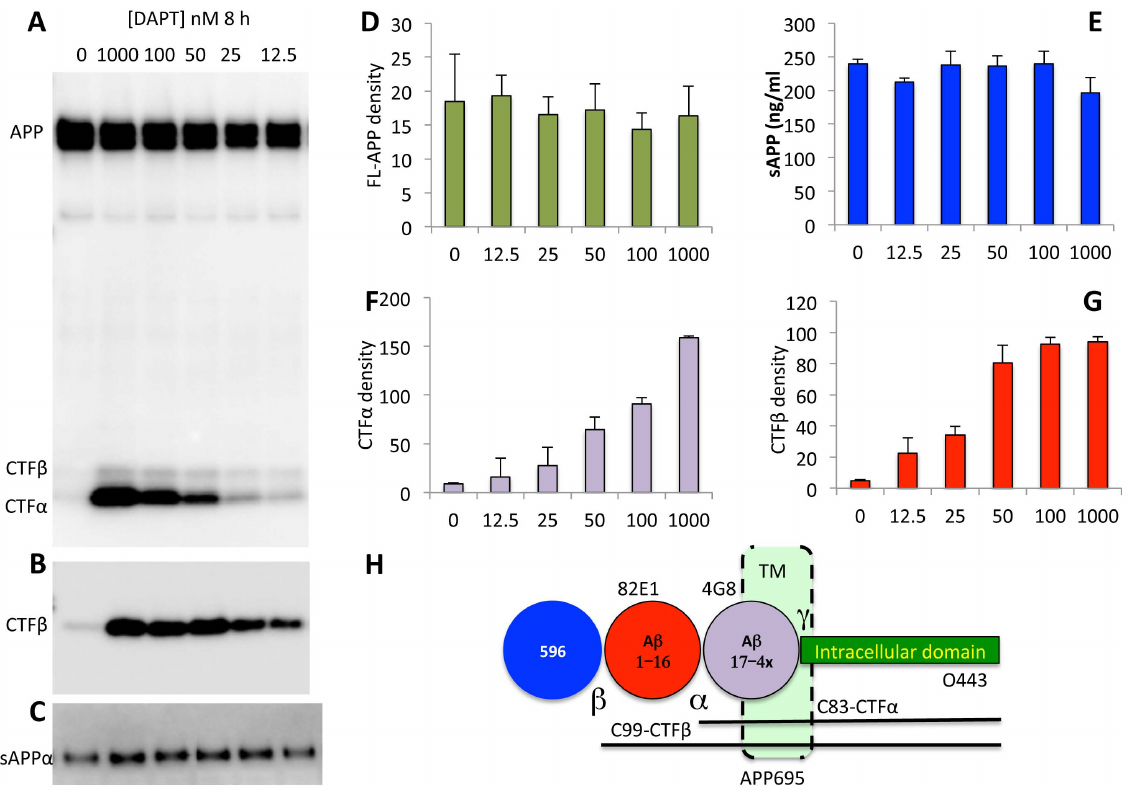
Figure 3. DAPT induced increase in A b does not alter APP processing. Western blots of cell lysates of SH-SY5Y cells from Fig 2 were detected in triplicates using the O443 antibody (A) and 82E1 (B); and media were analyzed with the WO2 antibody against A b 1-16 (C) as described in Materials and Methods. Full-length APP from A (D), CTF a from A (F) and CTF b from B (G) were quantified using the AlphaEase software and total sAPP (E; measured by an ELISA assay from R&D systems) were plotted as bar graphs. Full-length and secreted APP in panels D and E are not different from vehicle-treated controls. Tukey-Kramer analysis shows that there is significant dose-dependent increase in CTF b (p , 0.0001) and CTF a (p , 0.0001) with DAPT treatment. Note that CTF b reaches saturation at 50 nM DAPT whereas O443 does not saturate even at 100 nM. Panel H: Schematic of the APP695 protein as in Fig 1.